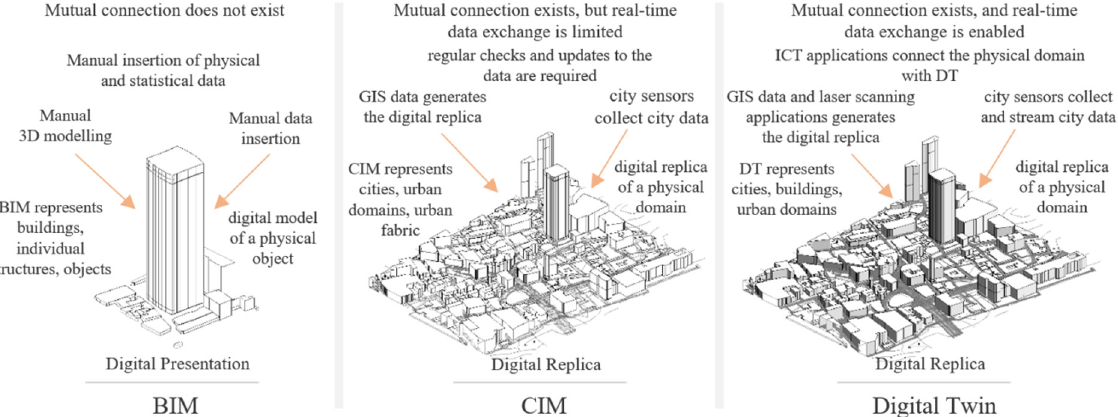
Figure 5. Applications of digitalisation in the built environment: BIM, CIM and DT. Source: